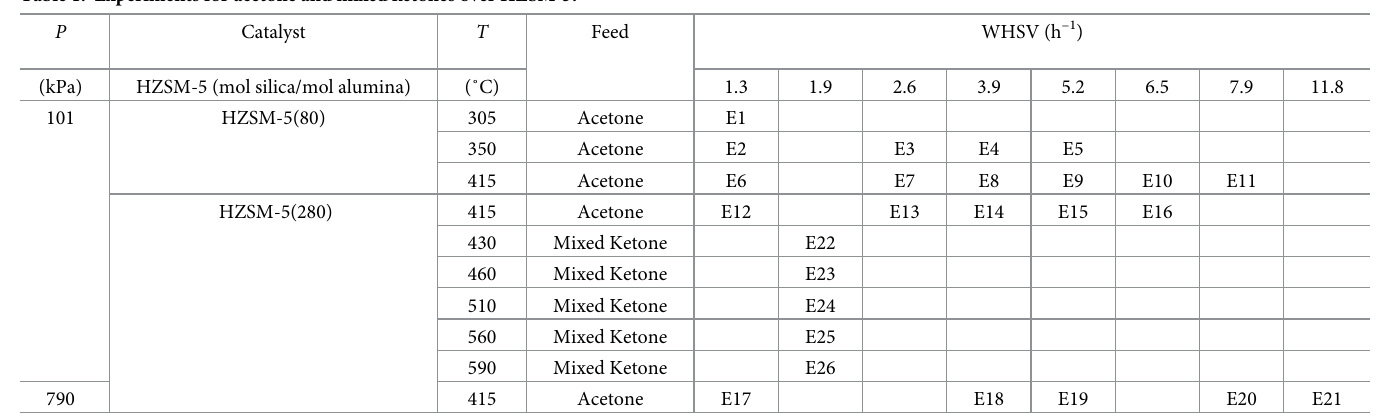
All columns have about 40- to 50- μ m-thick adsorption phases. The GC has three valves that split the carrier gas into six columns (Fig 2), which better separate the samples and conse- quently give more accurate results. All the reaction products were analyzed with this chro- matograph; however, heavier hydrocarbons (C5–C13) were lumped by carbon number. To identify all the isomers in the liquid phase, the GC-MS analyzed the liquid product samples. Before the analysis, all reaction products were cooled to 0˚C to ensure that all C5+ hydrocar- bons were in the liquid phase. A GC-MS analysis of the liquid phase typically determined that the liquid samples had over 100 compounds.